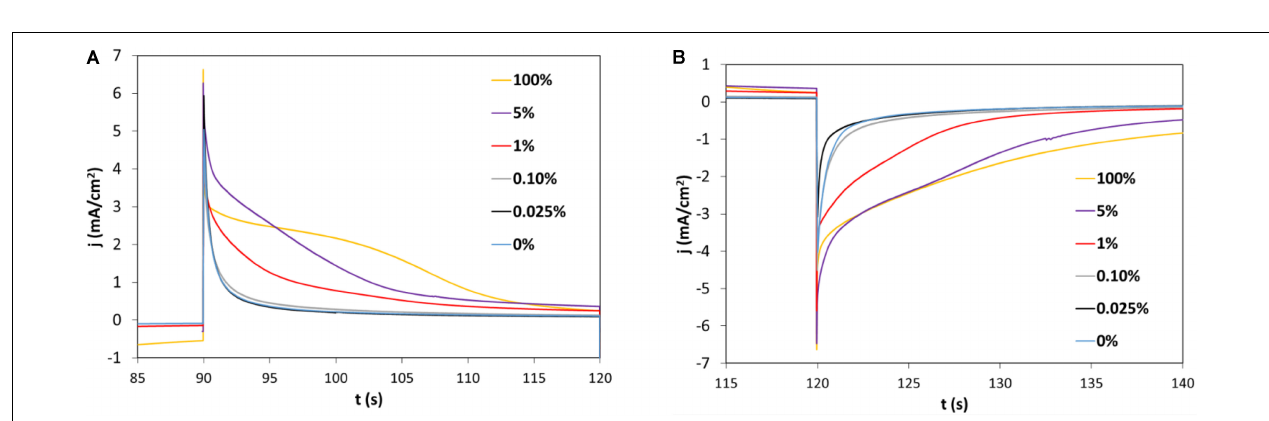
FIGURE 6 | Chronoamperograms (CA) of wt% hybrid PEDOT:PSS-V 2 O 5 cycled in LiTFSI:EMIM-TFSI (1:9) electrolyte/Pt vs. SCE with (A) the oxidation at E vs. SCE = +1.5 V and (B) the reduction at E vs. SCE = –1 V (second cycle is represented).